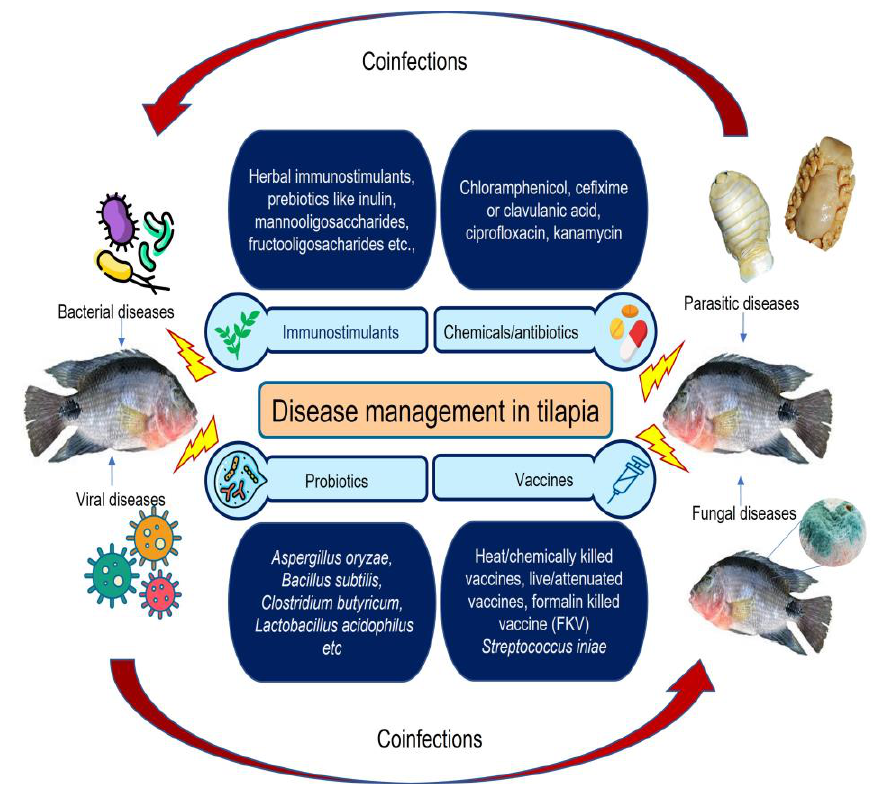
Figure 6. Steps involved in disease management in tilapia culture.